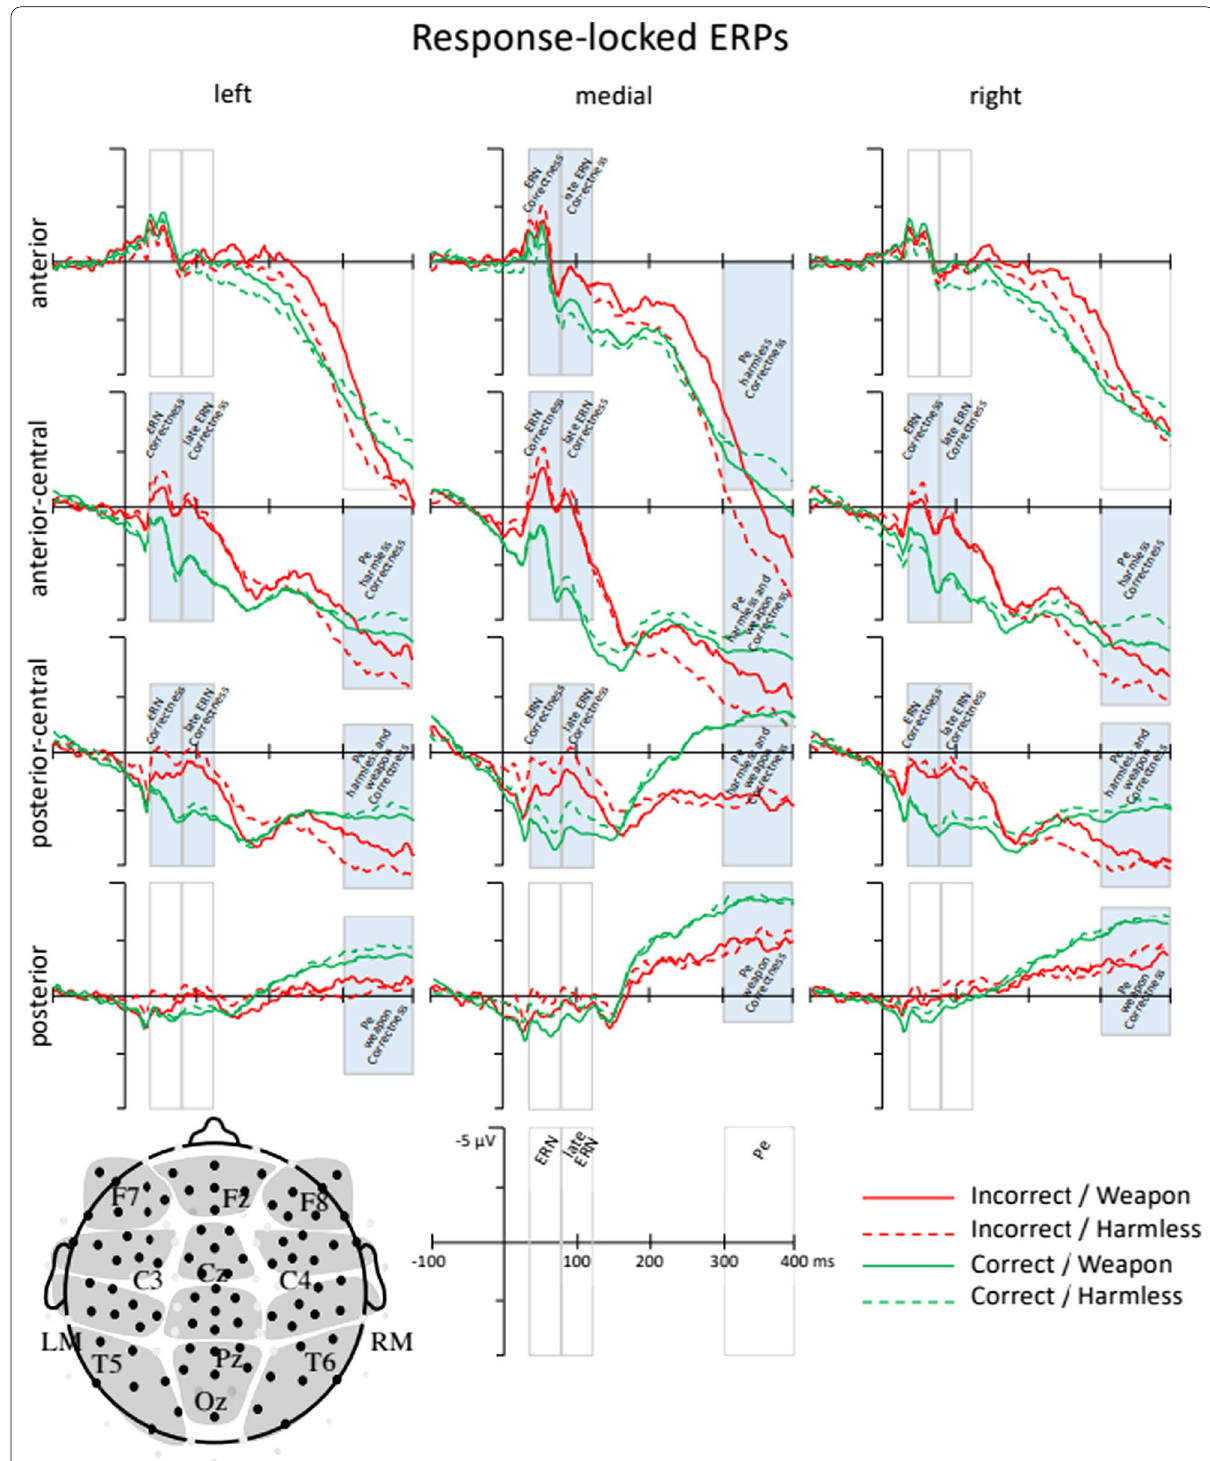
Fig. 6 ERP waveforms time‑locked to responses. The timing of the error‑related component measurement windows (ERN: 25–75 ms; late ERN: 75–125 ms; Pe: 300–400 ms) is indicated with gray rectangle. Correctness is distinguished by line color (incorrect type is distinguished by line type (weapon solid, harmless dashed). Incorrect responses elicited a larger negativity (ERN) and positivity (Pe) = = than incorrect responses, with the effect of correctness for harmless objects more broadly distributed and larger over some brain regions. Effect significance over each scalp region is indicated by a filled